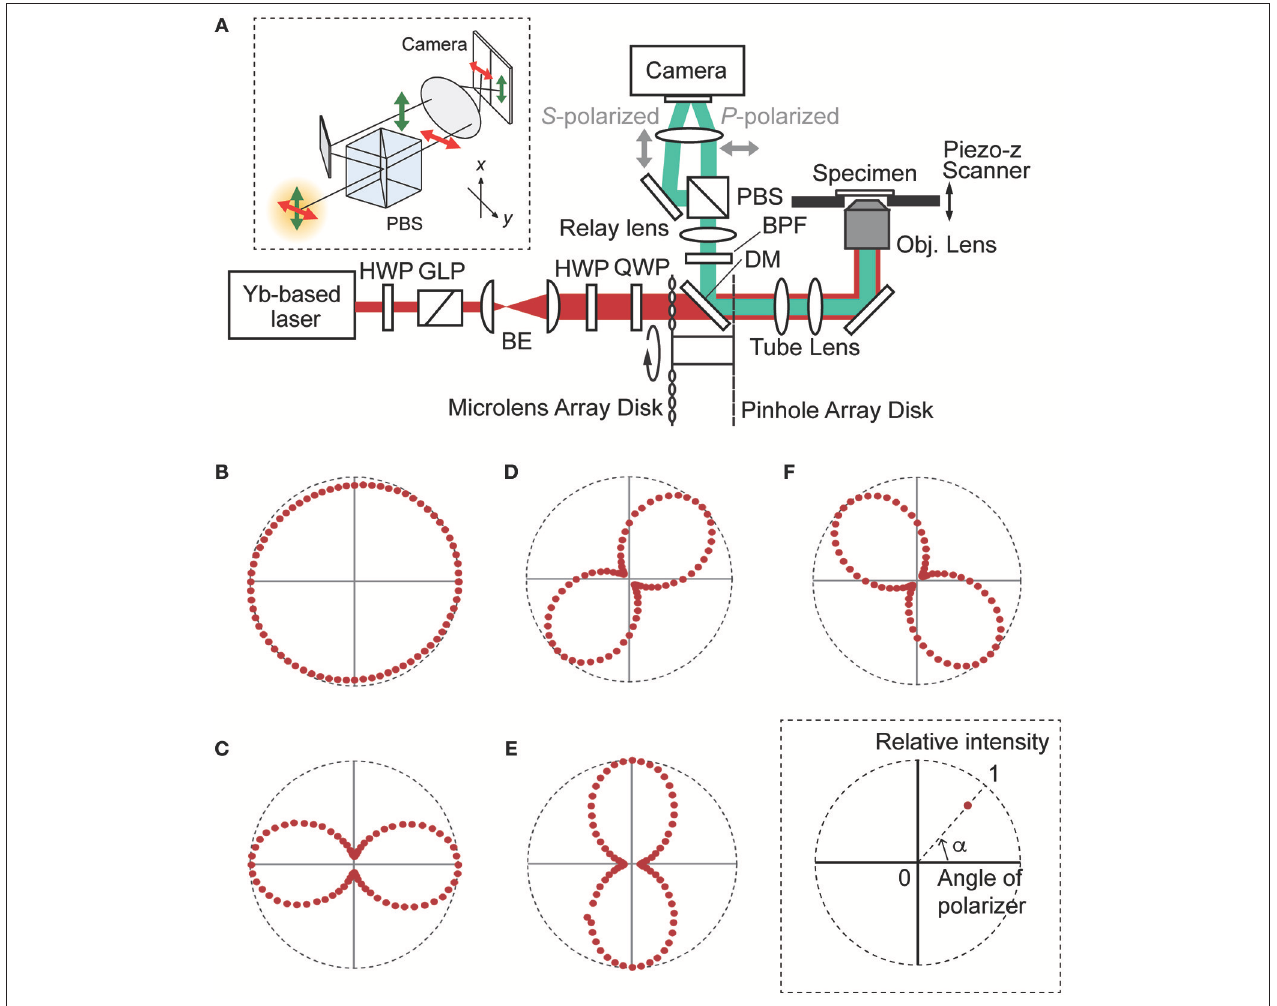
FIGURE 1 | (A) Optical setup of the developed TPM-SD system. BE, beam expander; BPF, band pass filter; DM, dichroic mirror; GLP, Glan-Laser polarizer; HWP, half-wave plate; PBS, polarizing beam splitter cube; QWP, quarter-wave plate. The upper inset panel is the schematic diagram of the polarization-resolving detection. (B–F) The polarization state of the incident light pulse at the specimen by adjusting the positions of HWP and QWP. (B) Circular polarization (ellipticity: 0.95). (C–F) Linear polarization for which the polarization angle from the horizontal axis of the FOV is 0 ◦ (ellipticity: 0.28), 45 ◦ (ellipticity: 0.27), 90 ◦ (ellipticity: 0.27), and 135 ◦ (ellipticity: 0.24), respectively. The lower inset panel indicates the schematic used for plotting the relative intensities on the polar